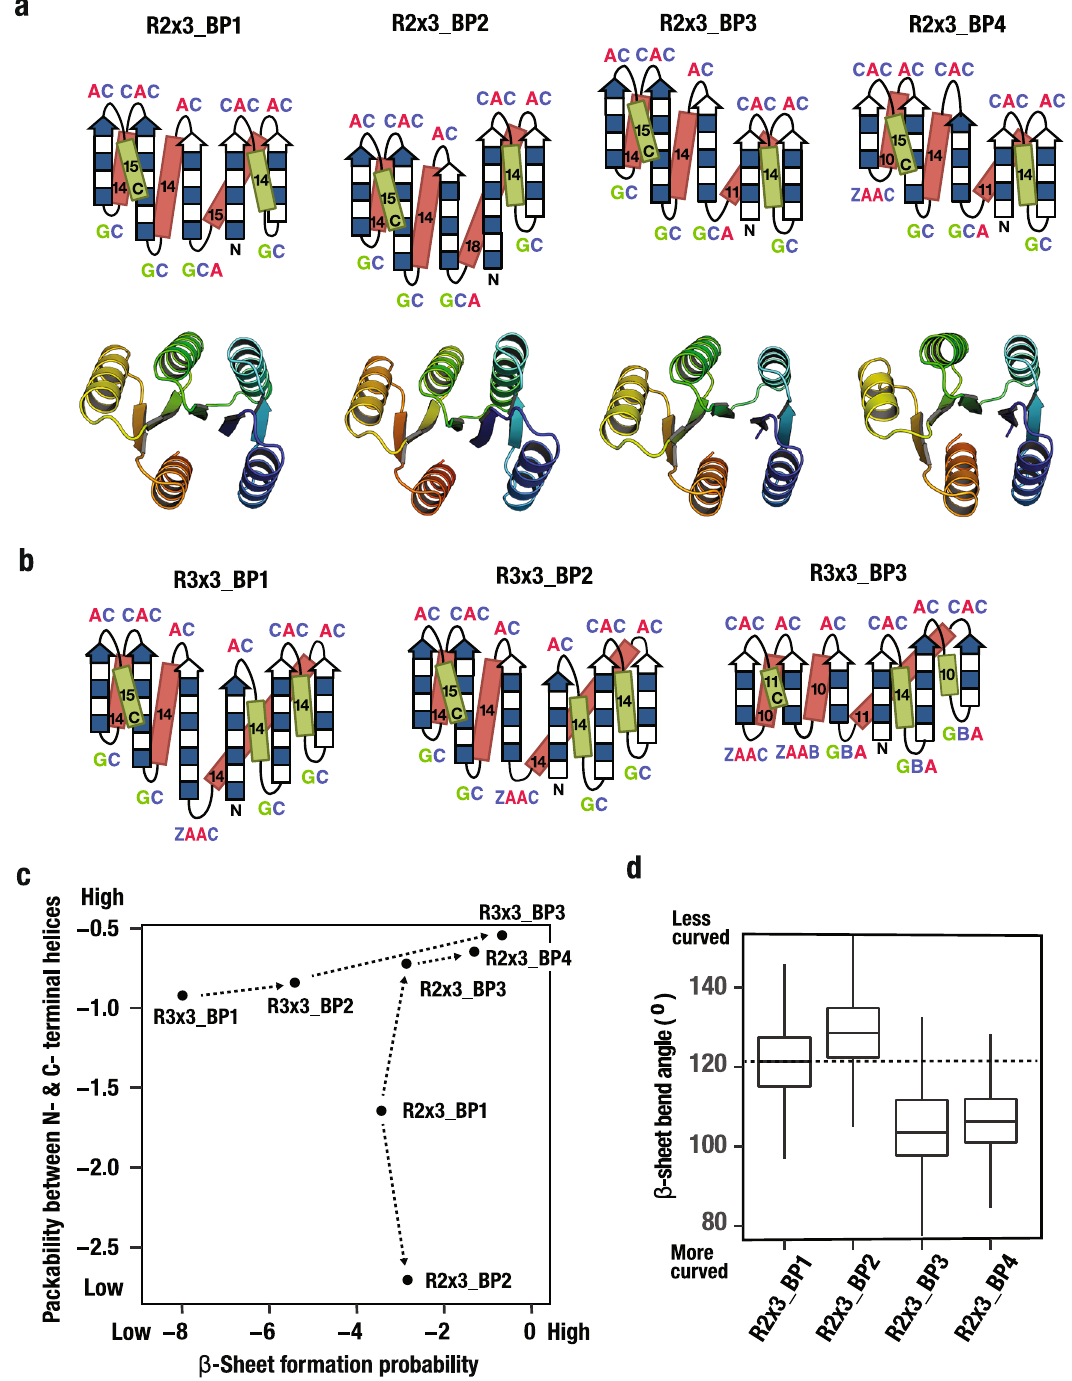
Fig. 6 Exploration of frustration-free blueprints. a Alternative backbone blueprints for the Rossmann2×3-fold, together with the averaged structures over the backbone ensembles generated from the blueprints. b Alternative backbone blueprints for the Rossmann3×3-fold. c β -sheet formation probability and packability between the N- and C- terminal helices for each blueprint. d β -sheet bend angle for each Rossmann2×3-fold blueprint (box plots: horizontal lines indicate median and upper and lower quartiles (Q 3/4 and Q 1/4 ), respectively; vertical lines extend to Q 3/4 + 1.5 x (Q 3/4 − Q 1/4 ) and Q 1/4 − 1.5 x (Q 3/4 − Q 1/4 ). n = 6174, 6136, 6768, and 8056 independently generated backbone structures for R2×3_BP1, R2×3_BP2, R2×3_BP3, and frustration-free blueprints for the Rossmann3×3-fold, allevia- Supplementary Fig. 15). The resulting ensemble was almost tion of the β -sheet frustration is even more important (Fig. 5b): frustration-free (Fig. 6c). β -sheet formation is frustrated in R3×3_BP1 and only slightly relieved for R3×3_BP2 by shortening the fourth strand length (Fig. 6b). To further reduce this frustration, the lengths of the β -strands were shortened to generate R3×3_BP3 (Fig. 6b and